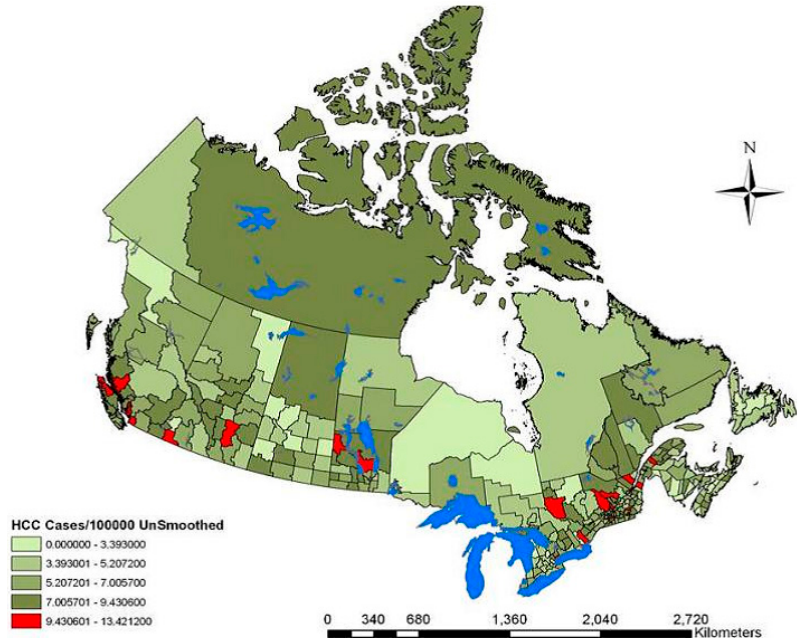
Figure 1. Canadian liver cancer cases per 100,000 within the 40+ population measured between 1996 and 2004. The map depicts the un-smoothed geographic distribution of cases.